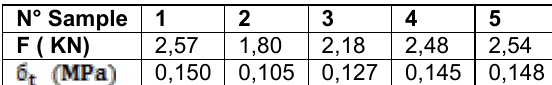
Figure 4. The variation of thermal conductivity :(a) Weight; (b) Specific heat.